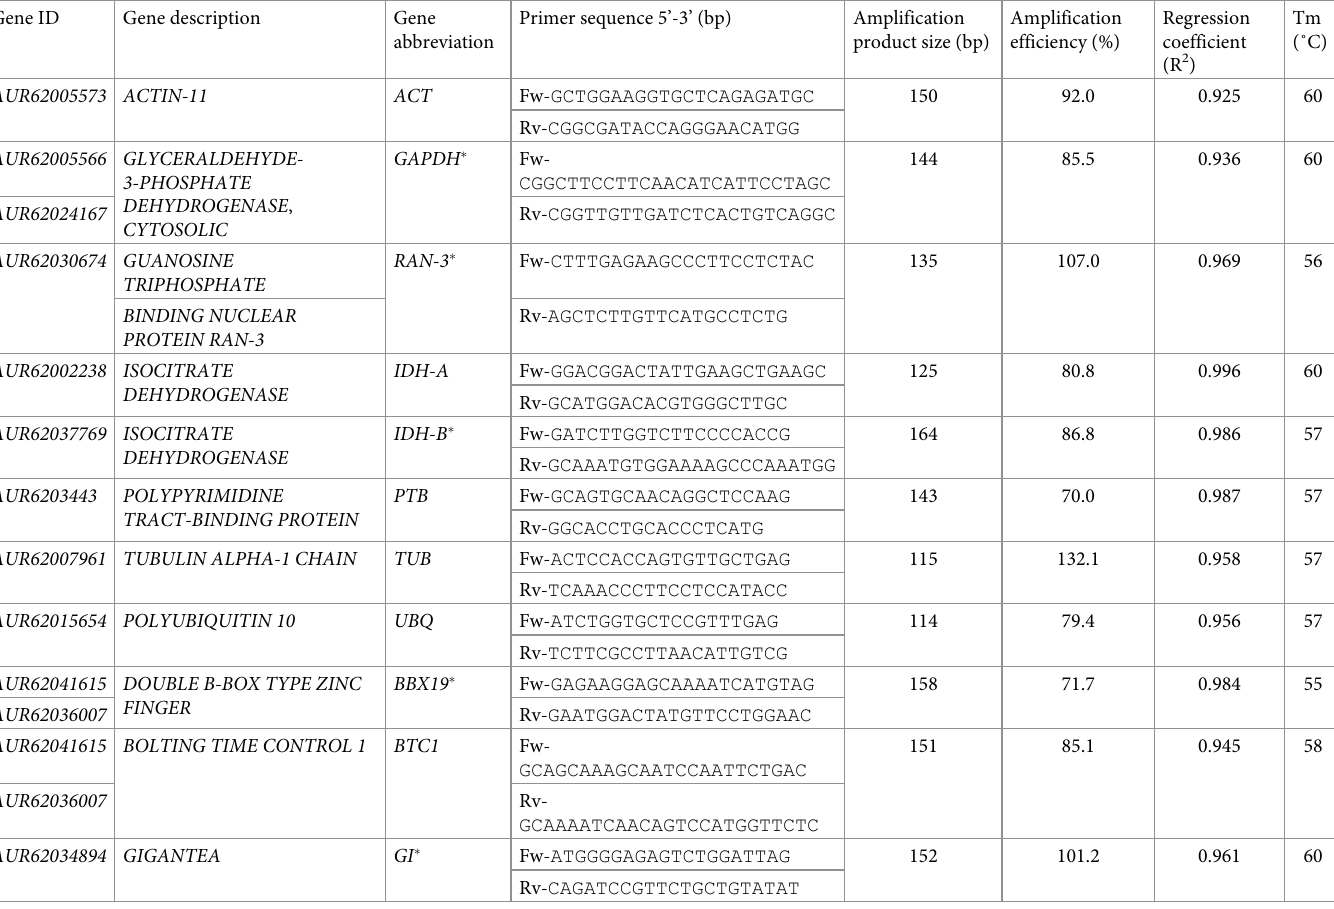
Table 1. Primer sequences, amplification product size and efficiency of the selected candidate reference genes and the target genes. Gene